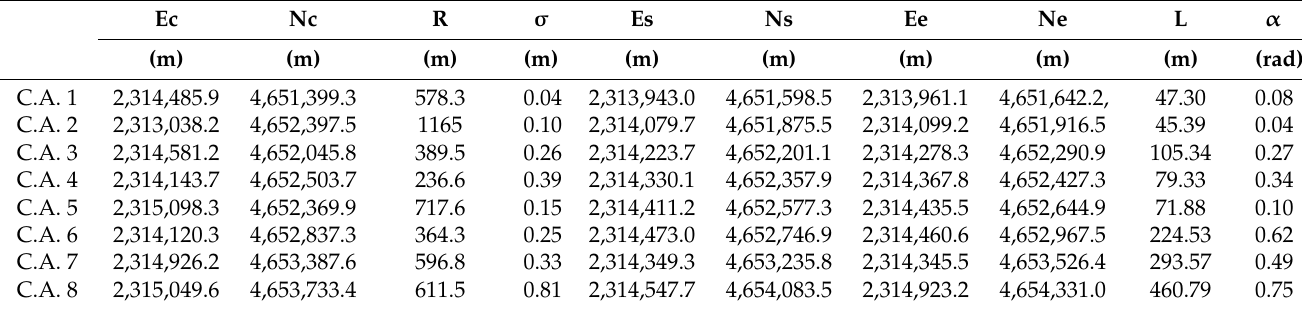
Table 3. Information related to circular